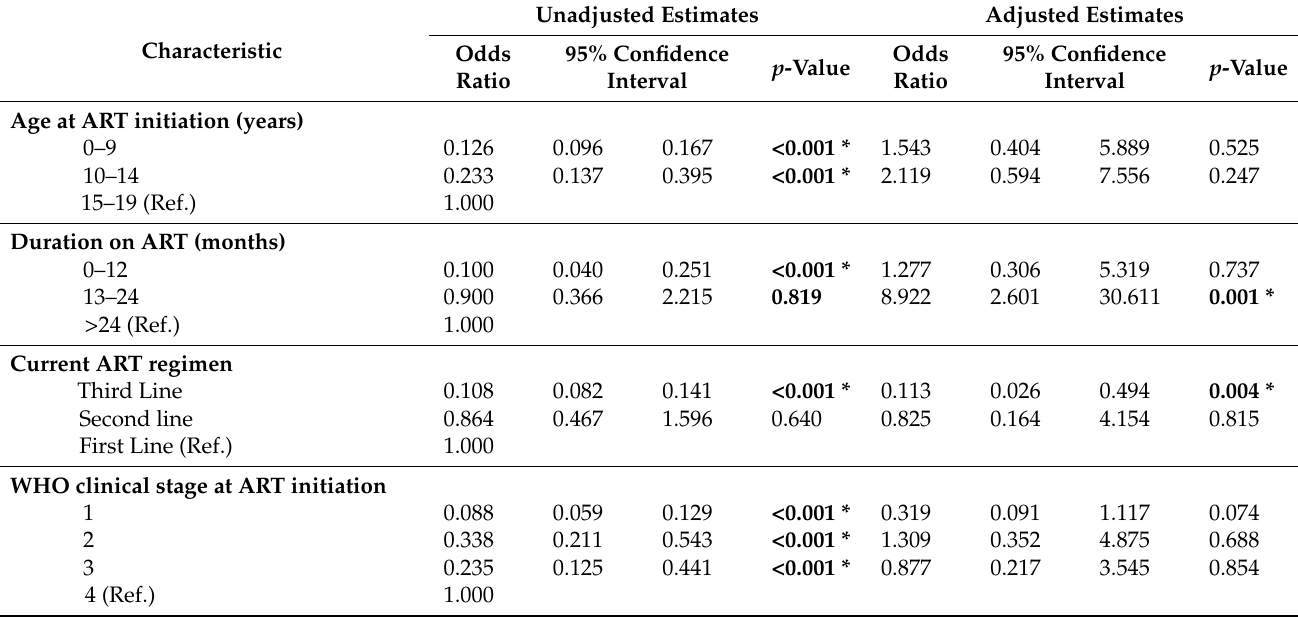
Table 2. Determinants of viral non-suppression among adolescents (10–19 years) on ART in Windhoek District, Khomas Region, Namibia 2019–2021 ( n =